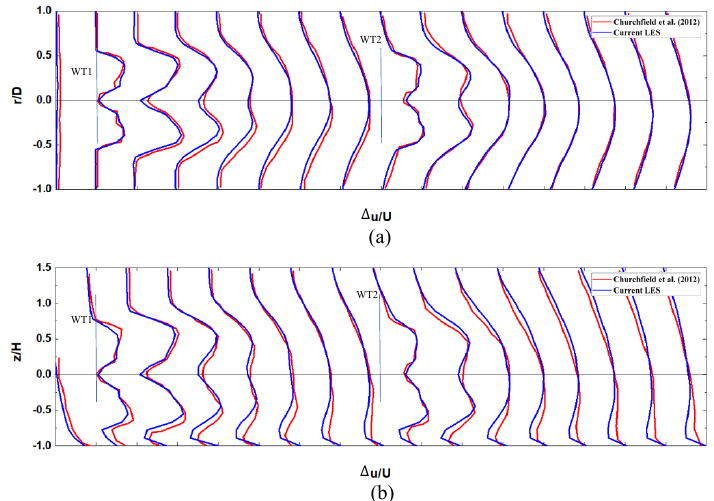
Figure 3. Time − averaged wake velocity deficit profiles normalized by the hub-height average freestream speed of 8 m/s: ( a ) horizontal profiles at hub height; ( b ) vertical profiles in the wake centerline [13].